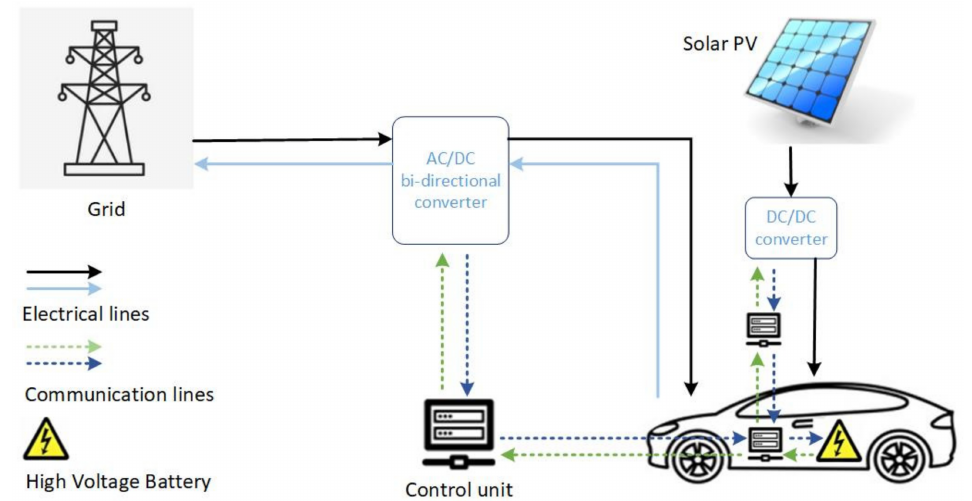
Figure 7. EV integration in the proposed